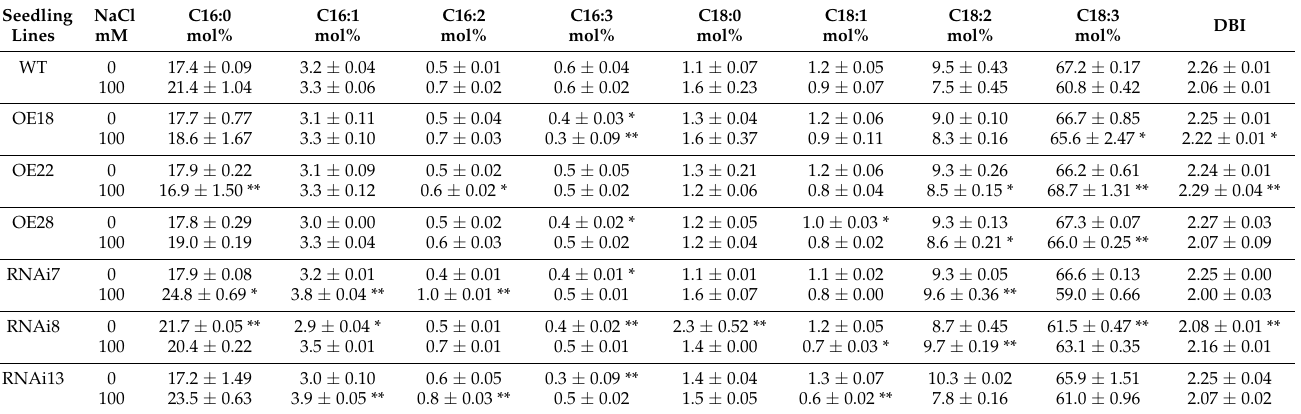
Figure 7. Effects of NaCl treatment on the composition of lipid classes in wild-type (WT), overexpres- sion (OE18, OE22, and OE28), and RNAi lines (RNAi7, RNAi8, and RNAi13). ( a ) Composition of lipid classes of rice seedlings in control and ( b ) composition of lipid classes of rice seedlings after 6 d of salt treatment. MGDG: monogalactosyldiacylglycerols; DGDG: digalactosyldiacylglycerols; SQDG: sulphoquinovosyldiacylglycerols; PG: phosphatidylglycerols; PE: phosphatidylethanolamine; PI: phosphatidylinositol; and PC: phosphatidylcholines. Data are means ± SE ( n = 3). An asterisk in- dicates a significant difference (LSD test, * p < 0.05 and ** p < 0.01) between wild-type, overexpression, and RNAi lines. Table 1. Constituent fatty acids of total lipids in the leaves of rice seedlings of wild type (WT), overexpression (OE18, OE22, and OE28), and RNAi lines (RNAi7, RNAi8, and